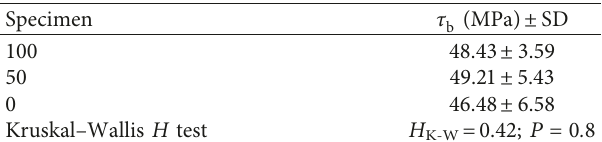
index ( ± SD) calculated for each b